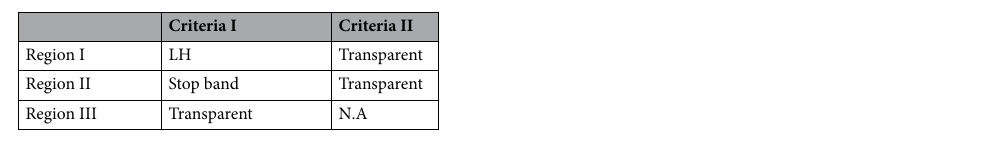
Table 2. Details of propagation characteristics observed in various simulation runs for different regions of dispersion curve.